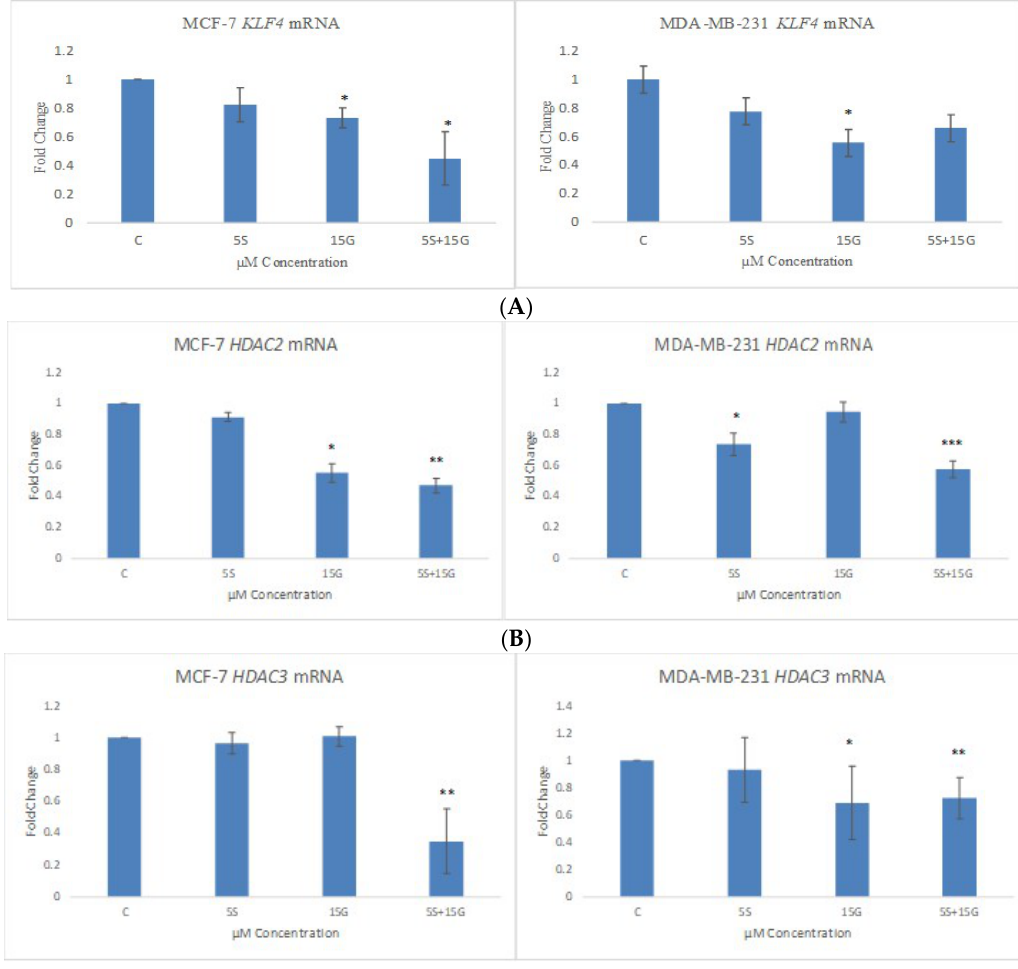
HDAC3 mRNA level. HDAC2 and